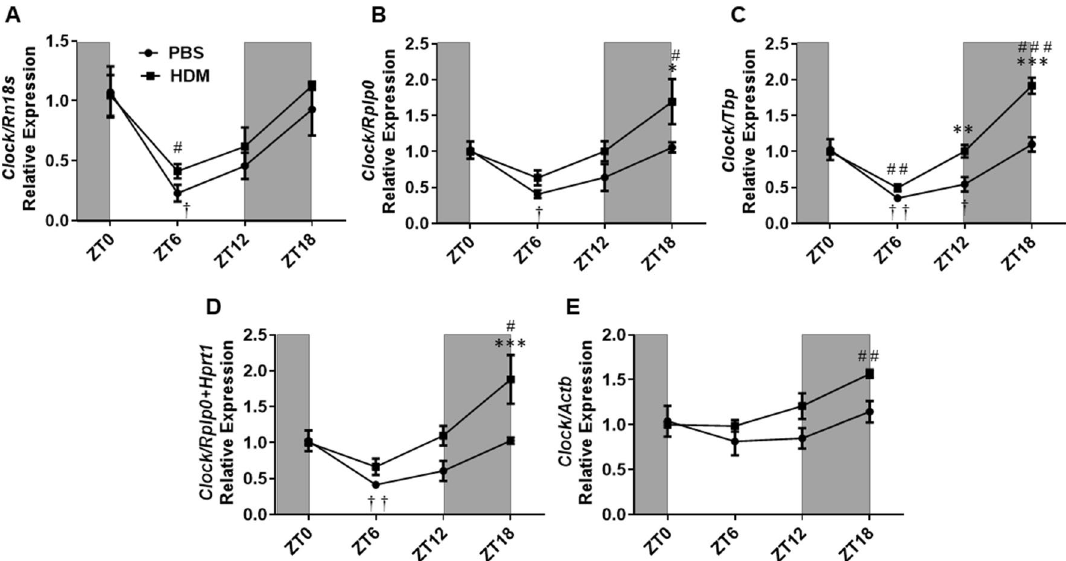
Figure 4. Clock gene relative expression in HDM versus PBS exposed mouse lung and data normalized with different reference genes. ( A ) Rn18s , ( B ) Rplp0 , ( C ) Tbp , ( D ) Rplp0 + Hprt1, and ( E ) Actb . Line graphs showing the relative expression of the Clock gene in both HDM versus PBS group. White and gray areas in the graph represents the light and dark cycle, respectively. Symbols † and # represent the statistical significance in temporal expression of Clock in the PBS and HDM group respectively at the marked time point when compared to the baseline (ZT0). Data are shown as mean ± SEM (n = 4/group; * P < 0.05, ** P < 0.01, *** P < 0.001, compared to respective control; † P < 0.05, †† P < 0.01, compared to ZT0 PBS; # P < 0.05, # # P < 0.01, # # # P < 0.001, compared to ZT0